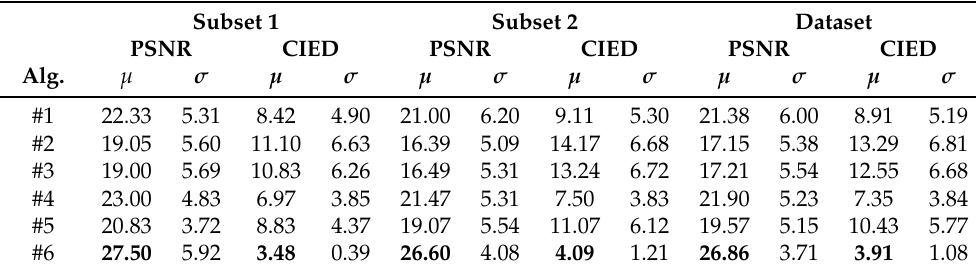
Table 2. Mean and Standard Deviations of the PSNR and CIEDE2000 (CIED) scores for each algorithm in Subset 1, Subset 2, and Dataset. Best results highlighted in